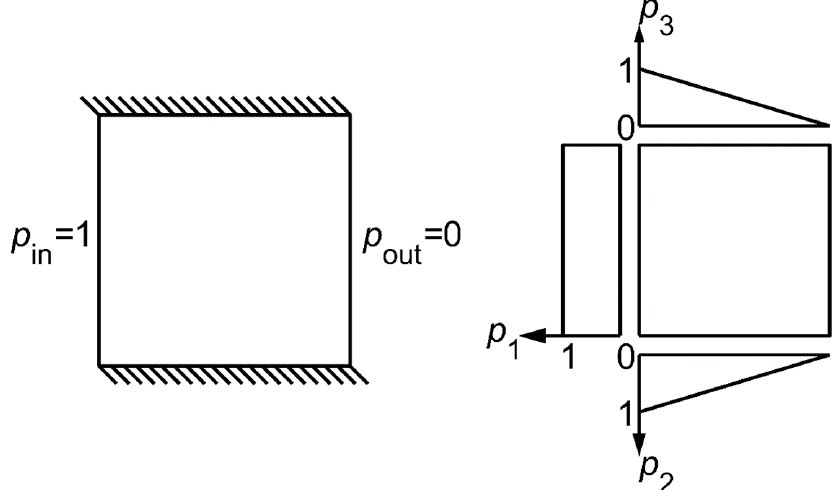
Figure 2. Boundary conditions used for numerical upscaling. ( Left ) constant pressure drop (CP) on a pair of opposing faces and no-flow boundary conditions on the remaining faces (Ups-CP). ( Right ) linear pressure (LP) conditions on all boundary faces (Ups-LP).